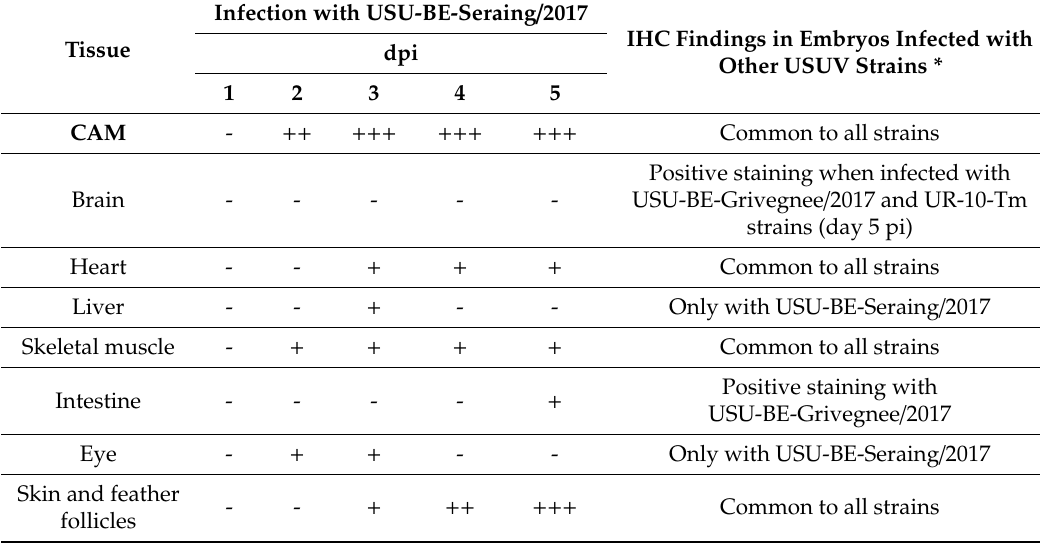
Table 2. Usutu virus antigens distribution in the selected tissues samples of infected chicken embryos, as determined by